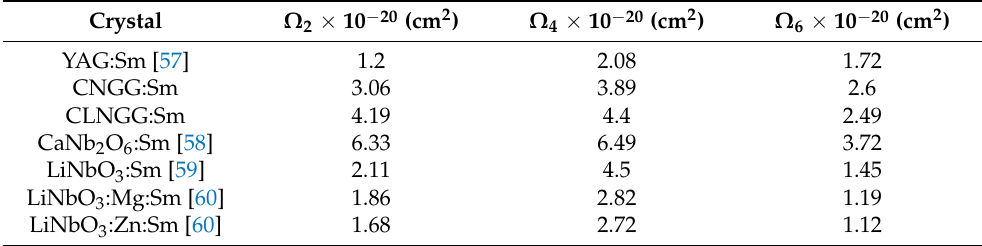
Table 2. JO intensity parameters for Sm 3+ in different oxide crystals with partially disordered structure (Reprinted with permission from Ref. [21], copyright 2017, Elsevier).